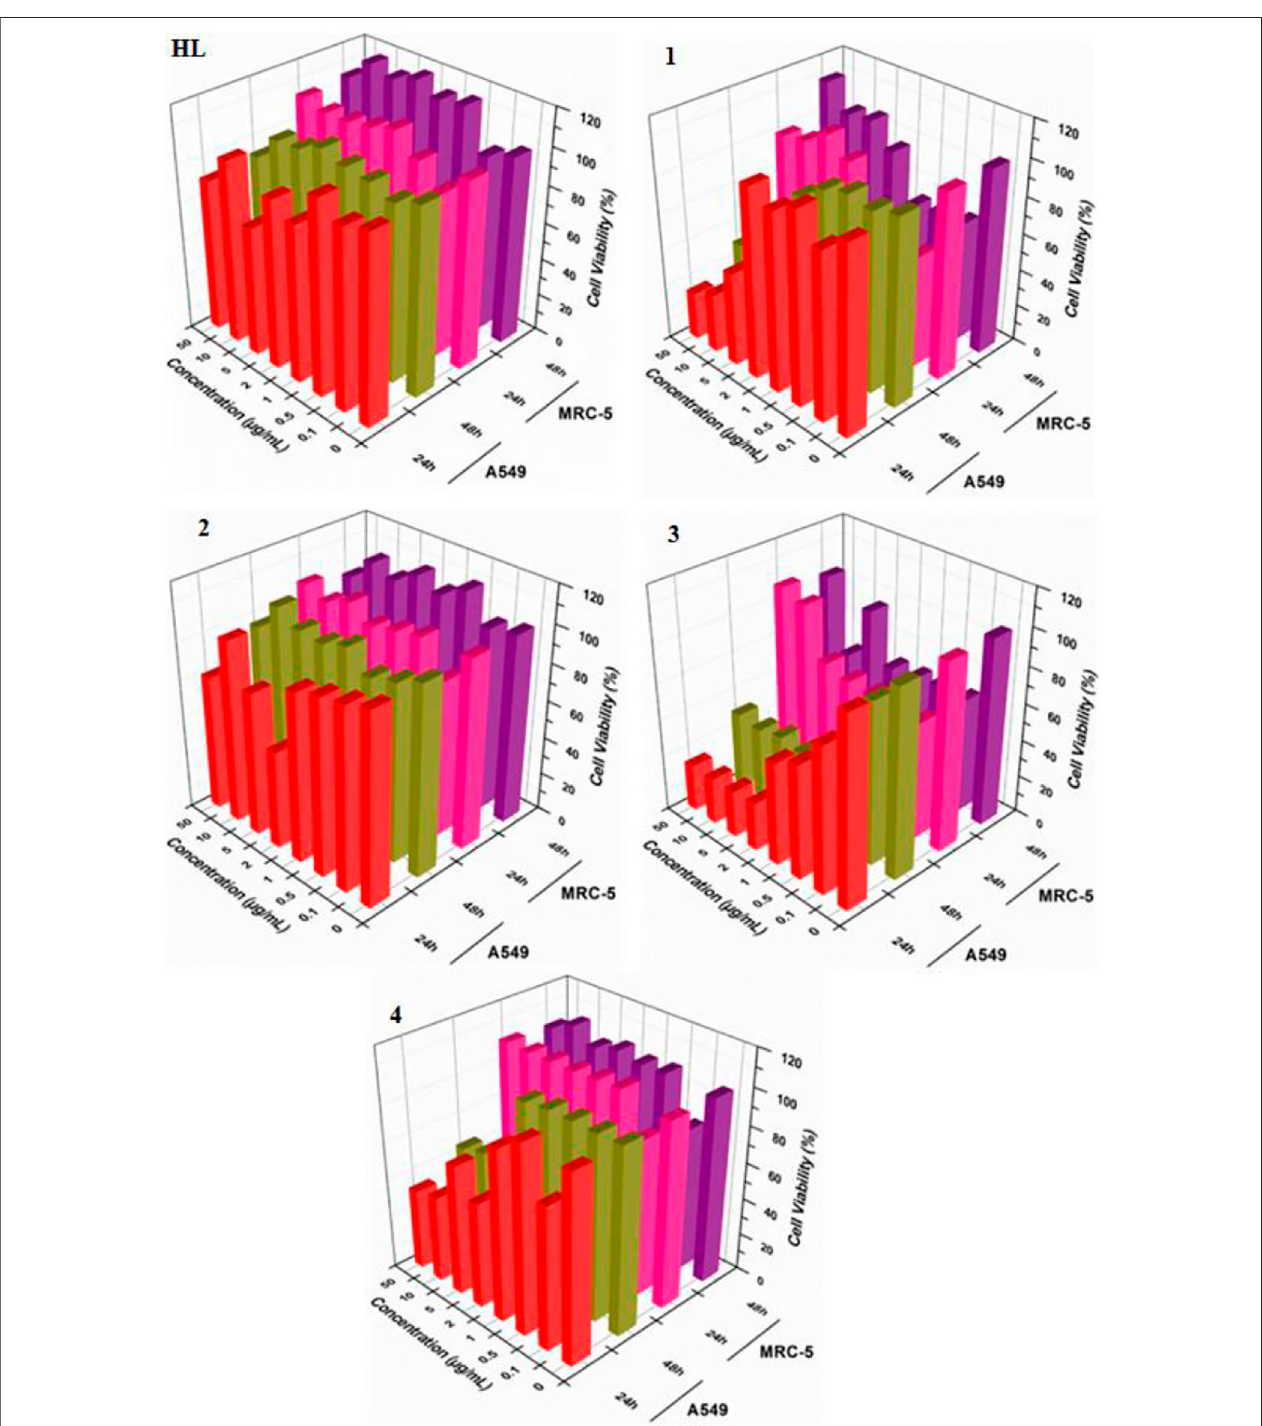
FIGURE 5 | Cytotoxic effects of ligand acid ( HL ) and synthesized complexes ( 1 – 4 ) against A549 and MRC-5.